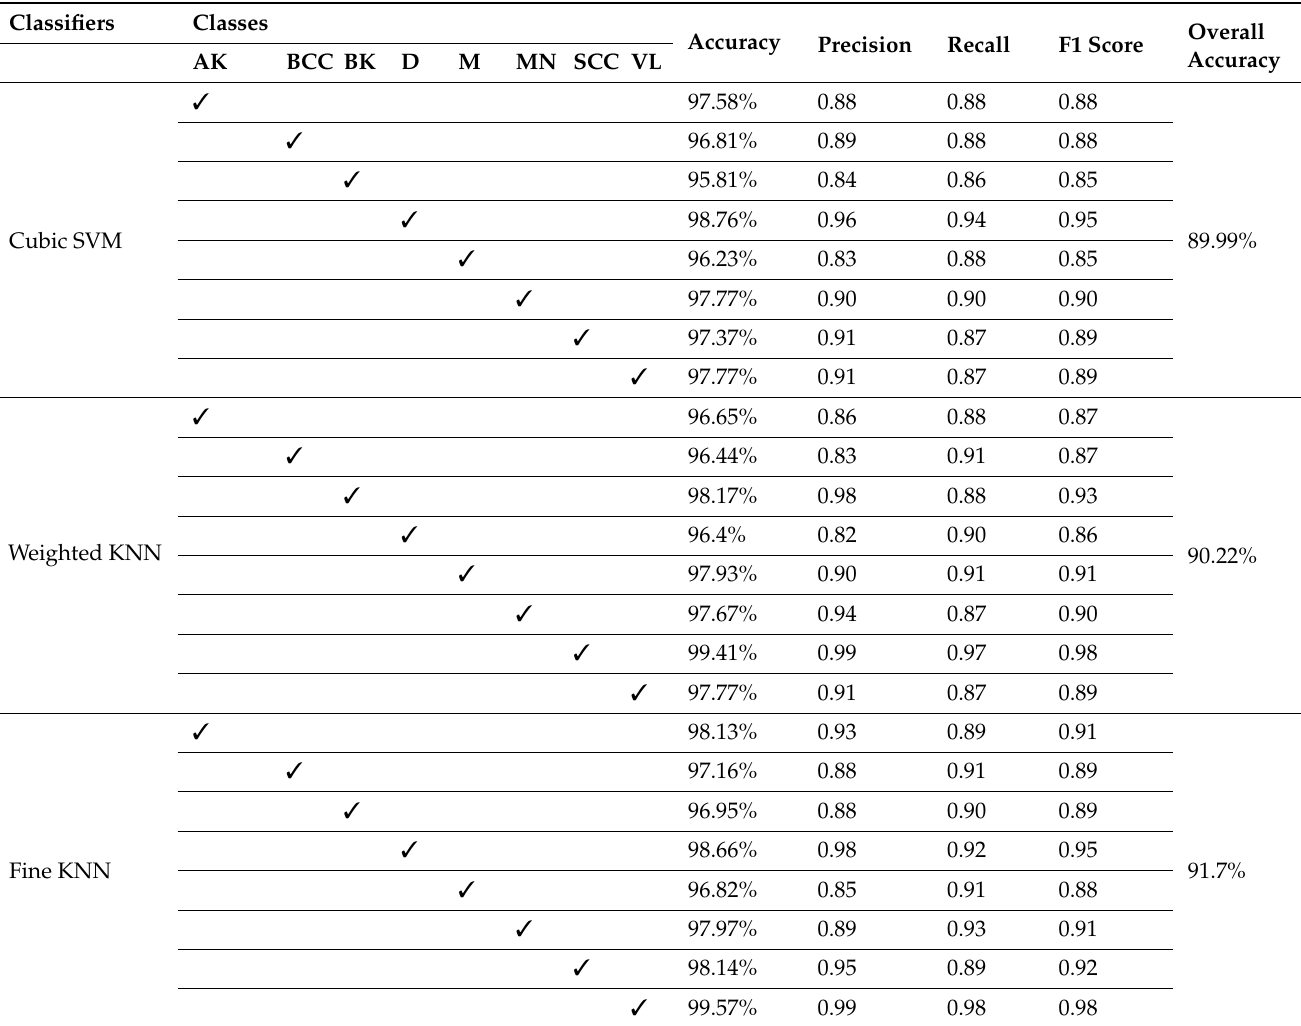
Table 11. Classification results on ISIC 2019